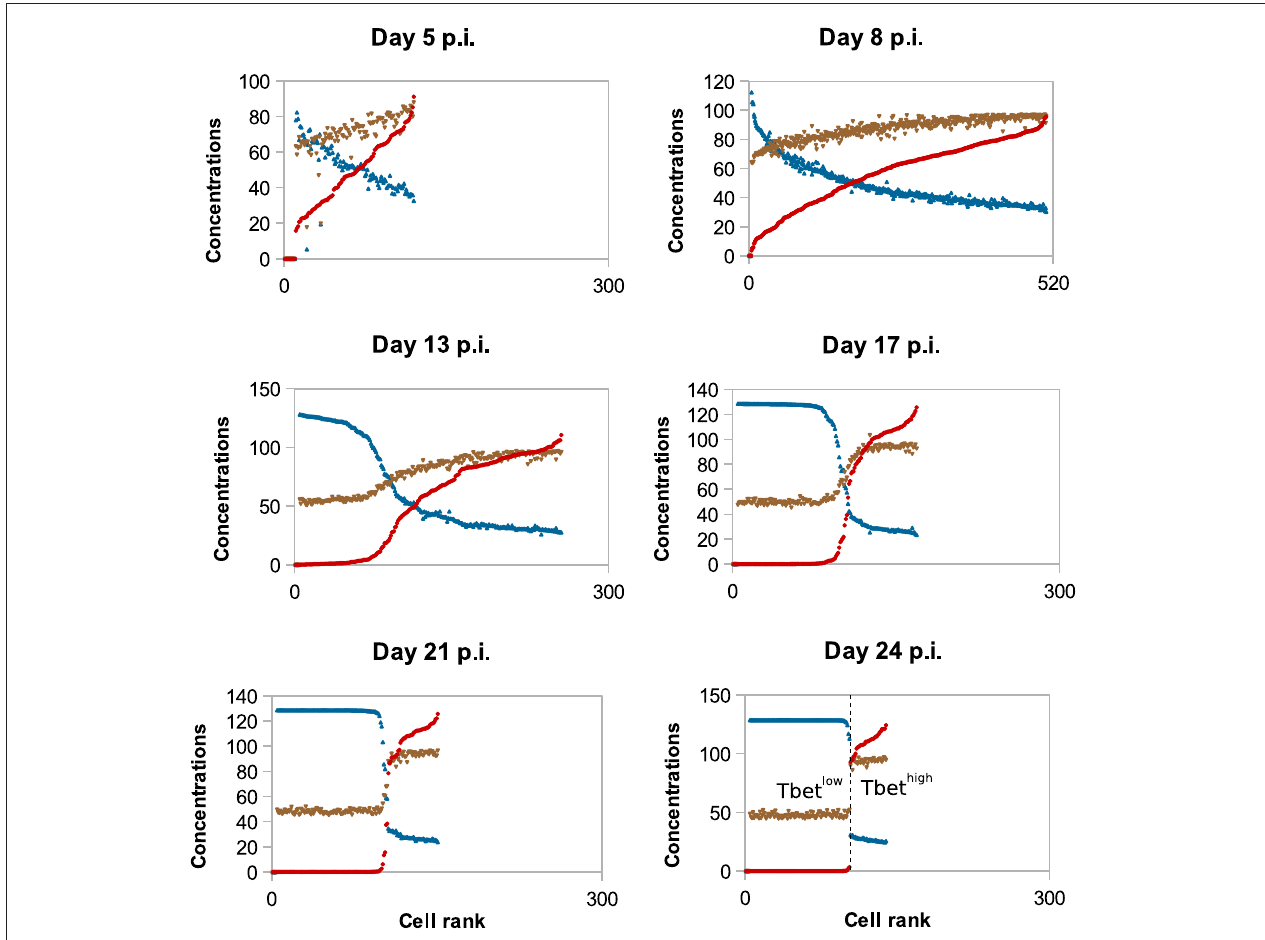
FIGURE 5 | Concentrations (mol/L) of Tbet (red), Eomes (blue), and Caspases (brown) in all cells, sorted (left to right) according to their Tbet concentration. In silico CD8 T-cell population on D5, D8, D13, D17, D21, and D24 post-infection are represented. To make it easier to read, Eomes and Caspases concentrations have been multiplied by factor